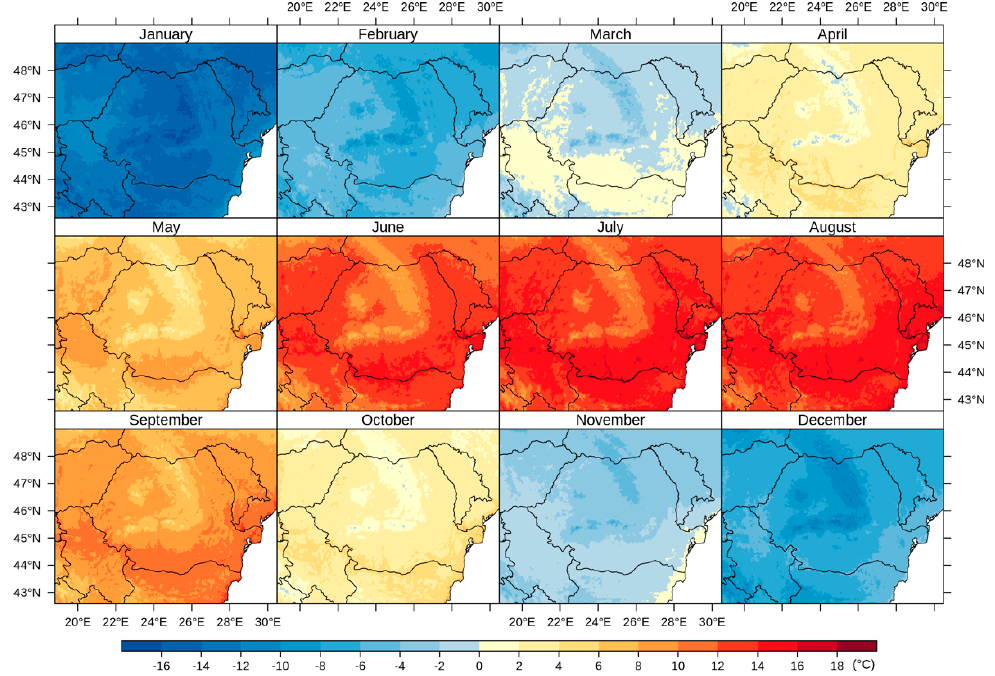
◦ C) from 2016 to 2017.